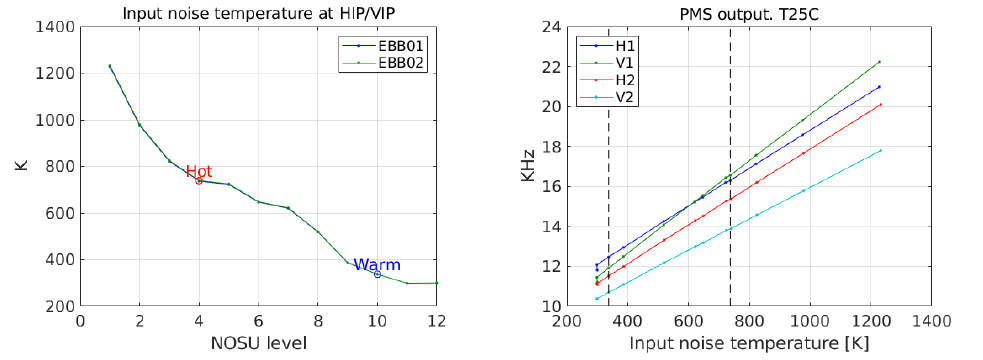
Figure 6. Left: Noise equivalent temperature injected at the HIP/VIP for each level. Right: Corre- sponding PMS measurements by all receivers.